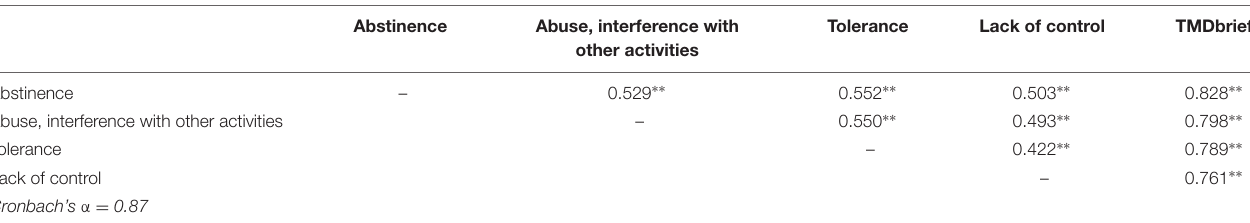
TABLE 6 | Factor correlation matrix (Ireland).